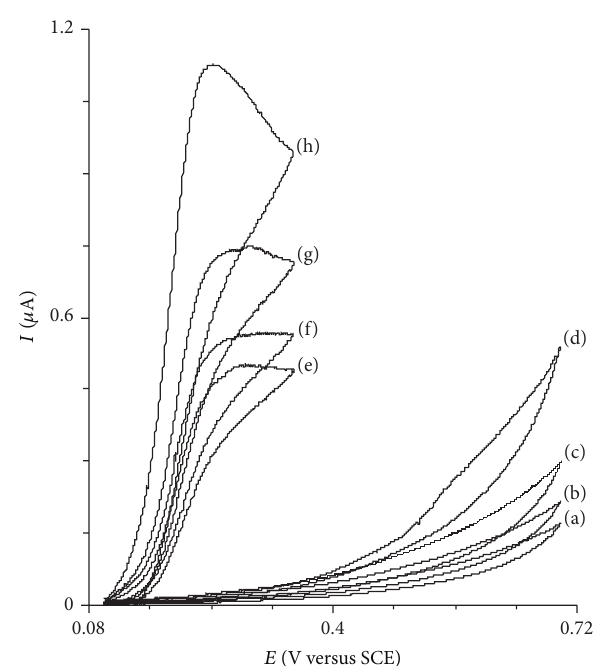
Figure 1: Cyclic voltammograms of (a) CPE, (c) MWCNT-CPE, (e) HTP-CPE and (g) HTP-MWCNT-CPE in a 0.15M phosphate buffer solution (pH 7.0). (b) as (a), (d) as (c), (f) as (e) and (h) as (g) in presence of 0.11mM of codeine. Scan rate: 25mVs −1